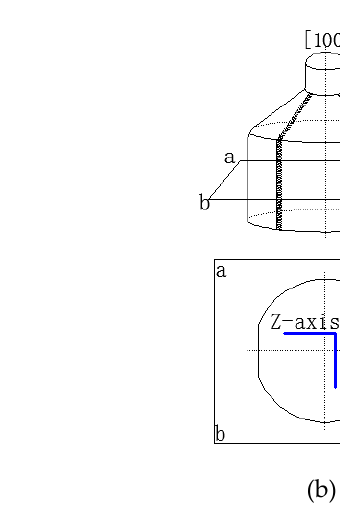
Figure 2. Scratching directions on LN different crystal wafers: ( a ) Z-cut, ( b ) X-cut.